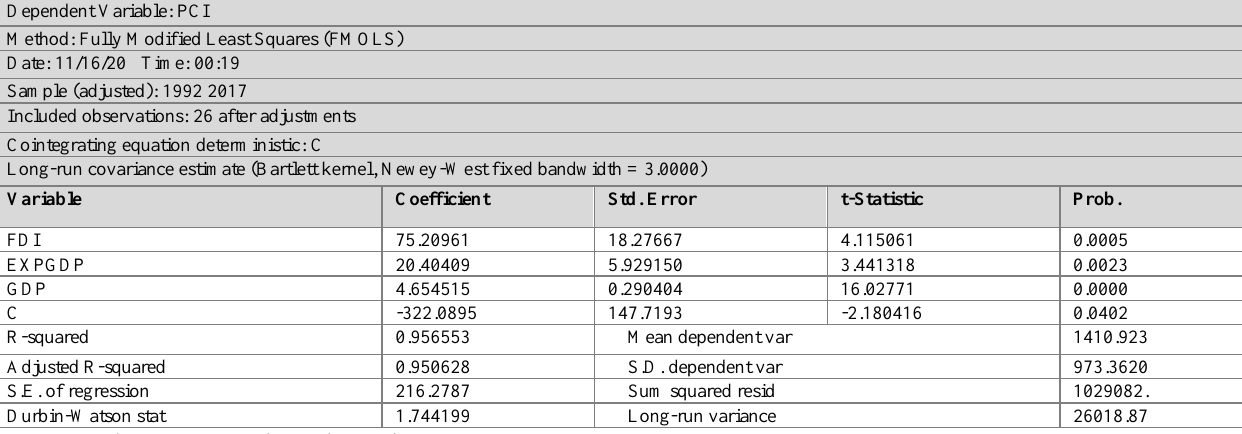
Welfare equation estimate proxied by per capita income